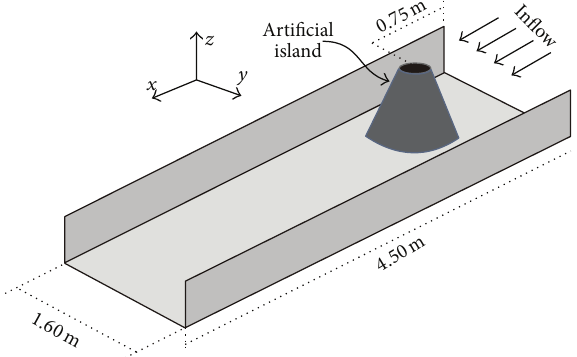
Figure1:Experimentalmodelsetup.Conicalislandinsidethecanal.